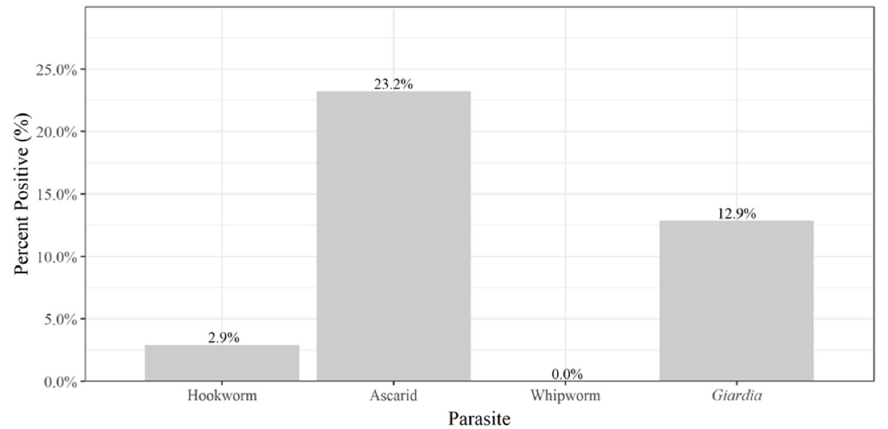
Figure 3. Prevalence of parasites detected in cats.